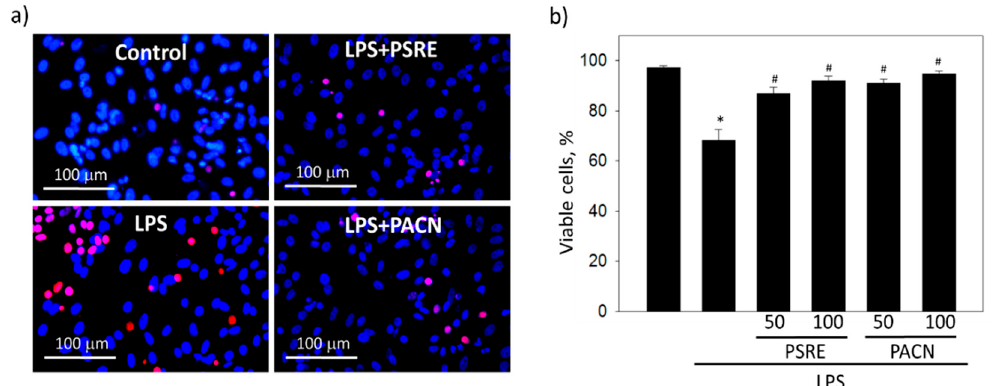
Figure 3. The effect of Pelargonium sidoides root extract (PSRE) and proanthocyanidins from PSRE (PACN) on the viability of gingival fibroblasts affected by bacterial lipopolysaccharide (LPS). ( a ) Representative fluorescent images after cell treatment with LPS and 100 µg/mL PSRE or PACN and nuclear viability staining; propidium iodide-positive necrotic nuclei are red, all nuclei are stained blue with Hoechst33342. ( b ) Quantitative viability results. Fifty and 100 represent the concentrations (µg/mL). The data are presented as means plus standard deviation of five experiments. *—significant difference compared to the untreated control, and #—significant difference compared to the LPS only treatment, p < 0.05.